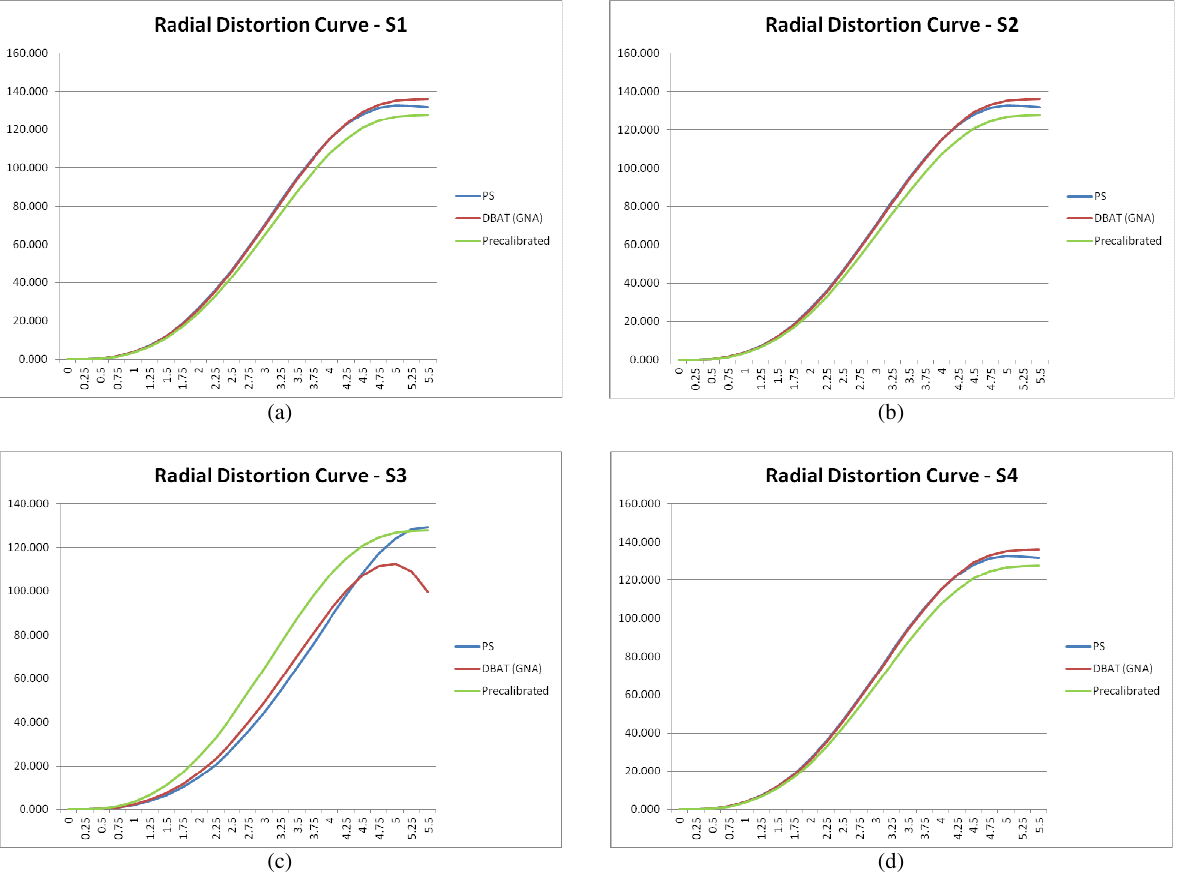
Figure 3. The radial distortion curves corresponding to the estimated K 1 -K 3 parameters for S1 (a), S2 (b), S3 (c), and S4 (d) Differences in terms of the distortion parameters were more may come from slight errors due to the conversion from PS to difficult to ascertain. To this end, the radial distortion curves DBAT distortion coefficient format. The DBAT format follows have been plotted in Figure 3. In the cases of S1, S2, and S4, the Photomodeler convention in presenting distortion DBAT managed to generate a similar distortion profile as that parameters as polynomial coefficients scaled by the focal of PS, with small differences beginning at the radial distance of length, while PS calculates the normalised value of these 4.25 mm from the projective centre. These minor differences parameters. Differences with the precalibrated values are to